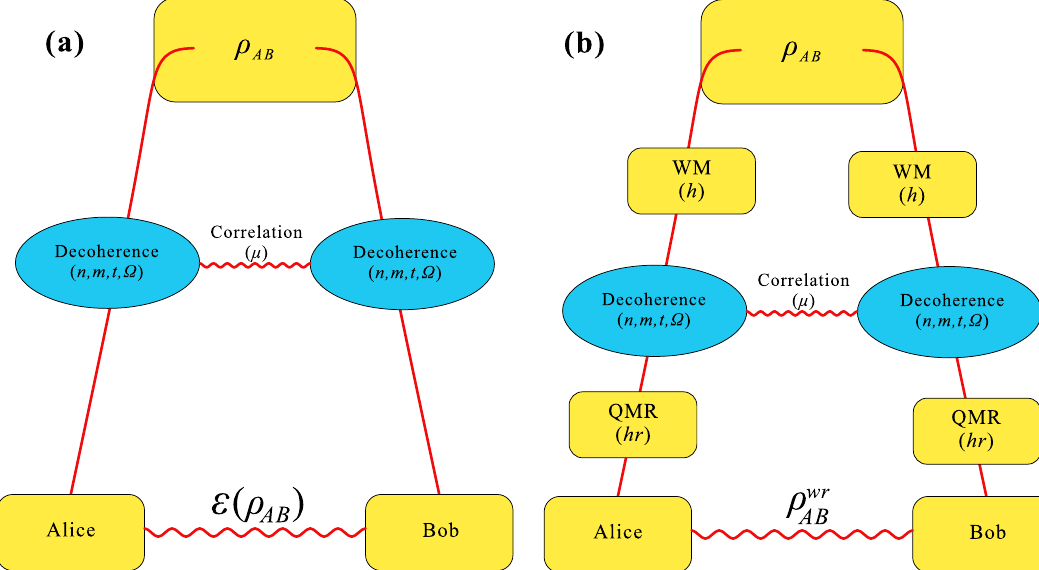
Figure 1. (Color online) ( a ) Evolution of nonlocal quantum correlations in noise channel. Two-qubit system state ρ AB are sent to Alice and Bob through a correlated SGAD channel ε . Decoherence in the quantum channel weakens the nonlocal quantum correlations of the output state between Alice and Bob ε(ρ AB ) . ( b ) Recovering nonlocal quantum correlation from decoherence. The weakening of nonlocal quantum correlations caused by correlated SGAD channel can be recovered by sequentially performing local WM and QMR on the subsystem state before and after they undergo the